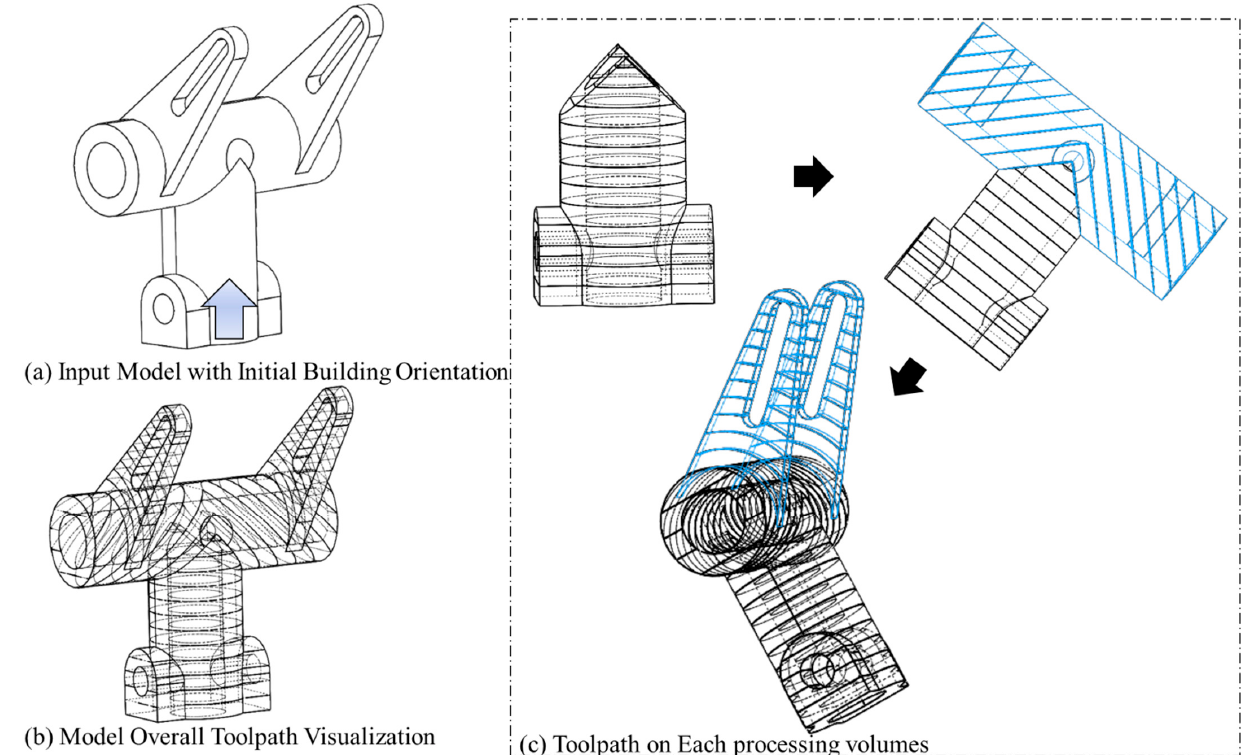
Figure 15. Trajectory accumulation on model with first defined initial building orientation for model (b).